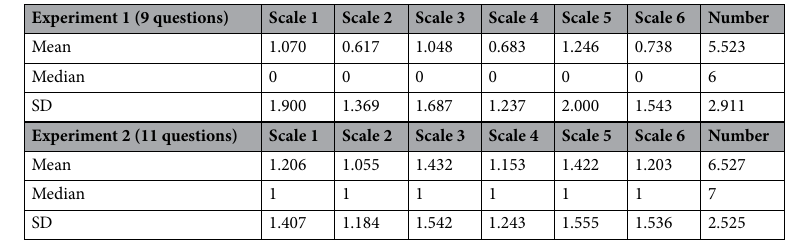
Table 2. The number of uses of round numbers in answering